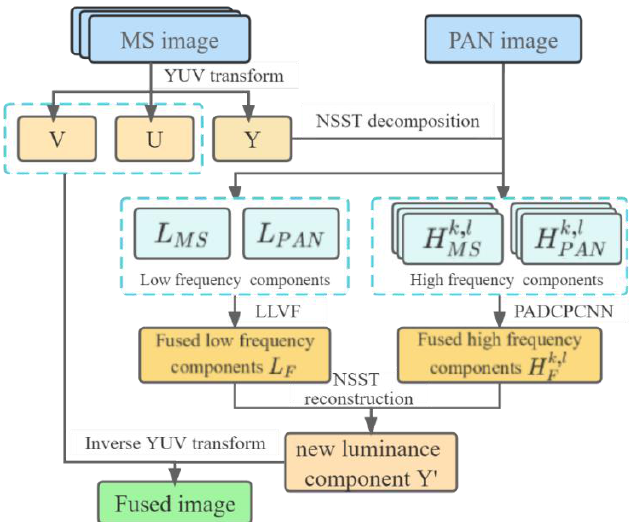
Figure 3. Flowchart of the method design.